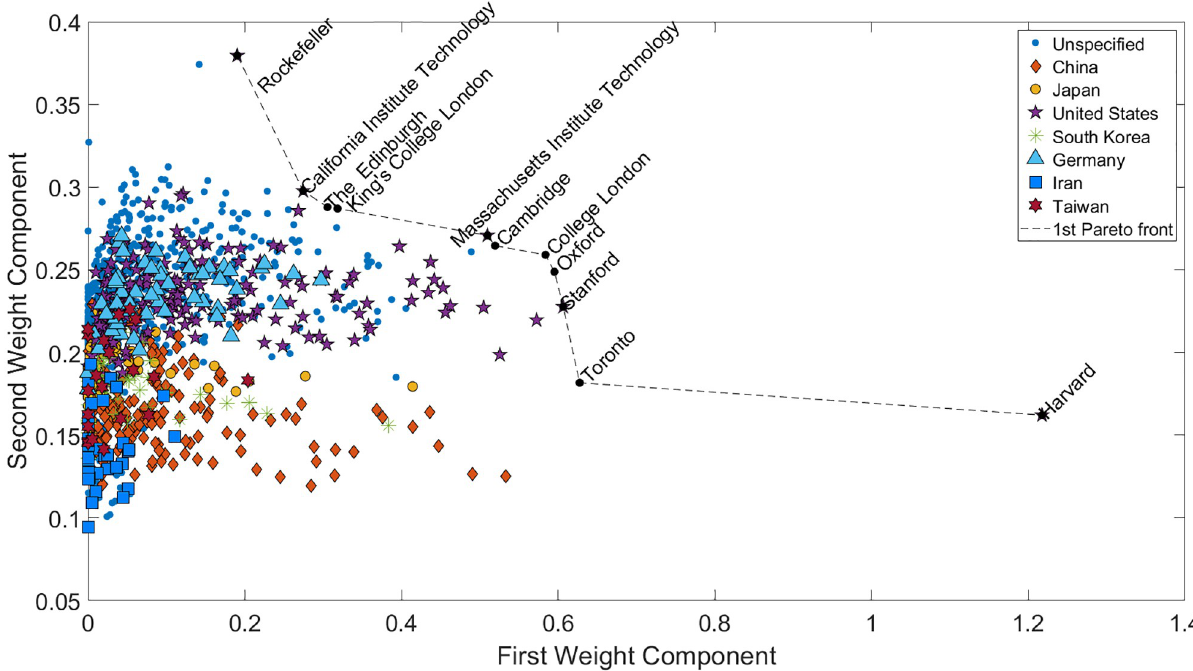
Fig 14. Pareto front of the sparse NMF. The α = 0.4 and β = 0.4 parameters are selected to incorporate a fair number of members to the Pareto front, and also have most of the objectives incorporated into a component.